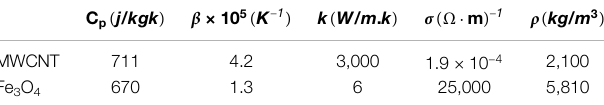
TABLE 1 | Properties of hybrid MWCNT and Fe 3 O 4